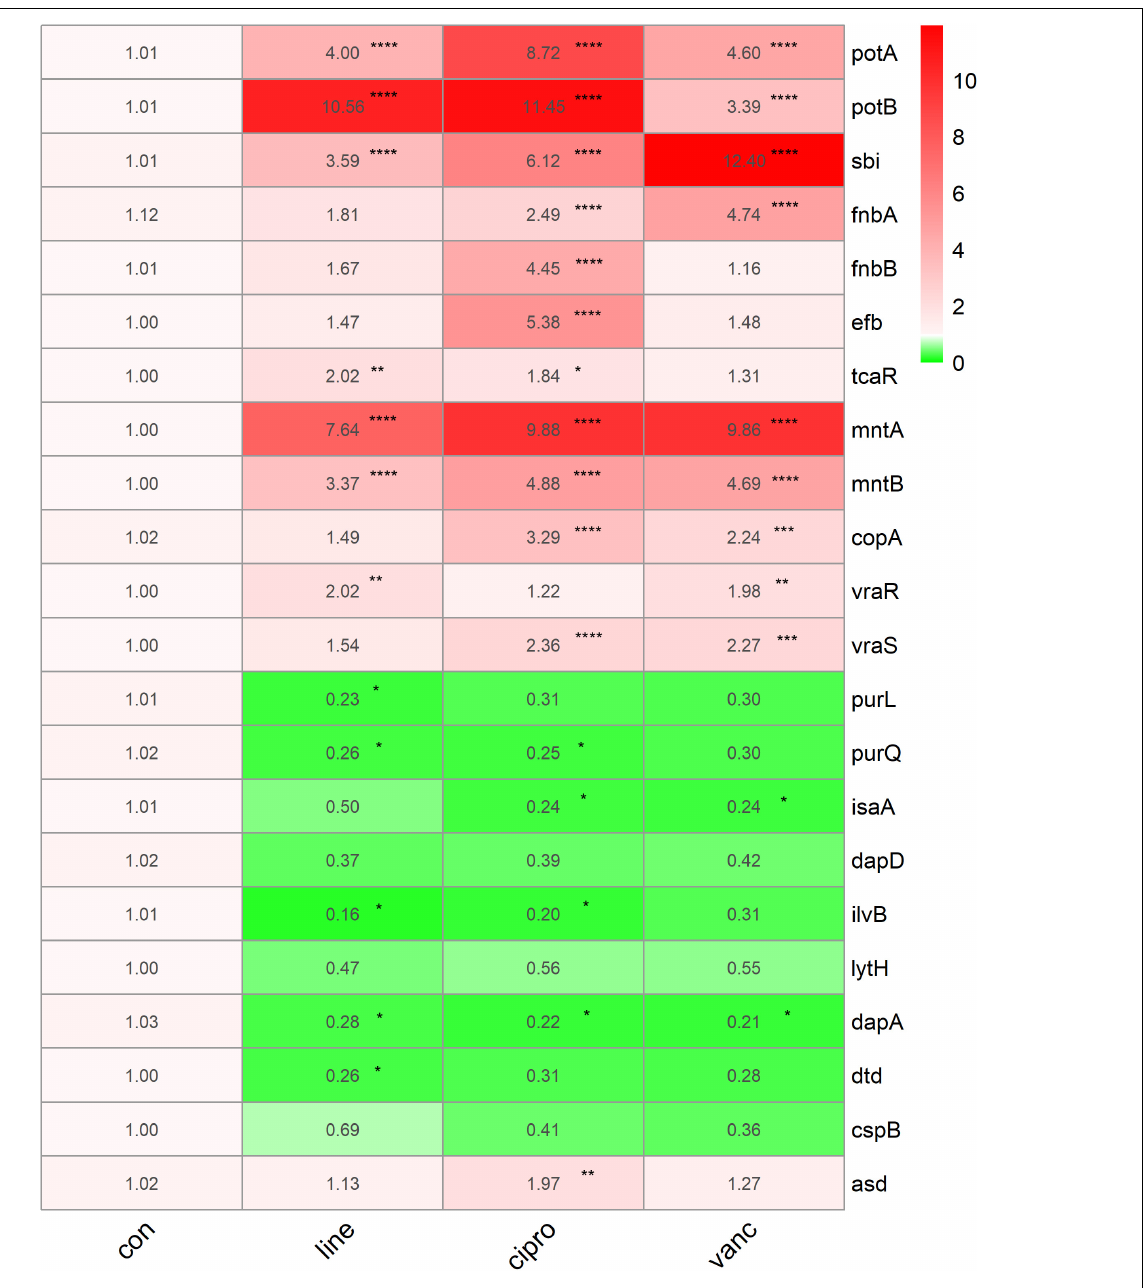
FIGURE 9 | The qPCR data of antimicrobials treated ST1792. The gyrB normalized transcription after biofilm formation. Statistical significance was calculated using ANOVA with Dunnett multiple column comparisons. * p < 0.05; ** p < 0.01; *** p < 0.001; **** p < 0.0001 vs. non-treated control.